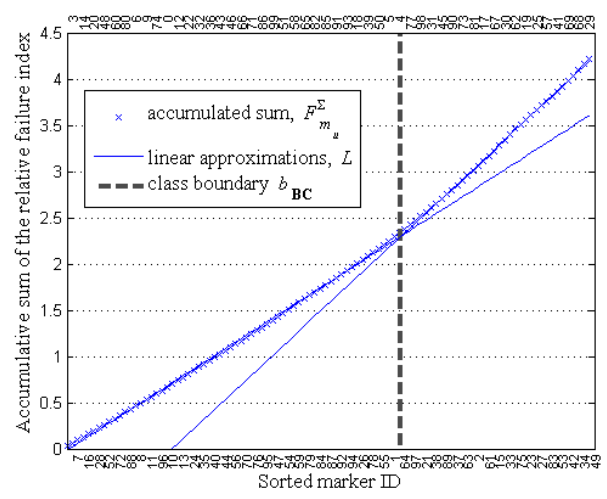
Fig. 11. Accumulative sum of the relative failure index dependency on marker recognition results sorted using three-fold criteria. Note: marker IDs are shown pair wise at the bottom and the top of axis; the best LMS approximation by two linear functions is indicated by solid lines; boundary between B and C marker classes is indicated by dash line.